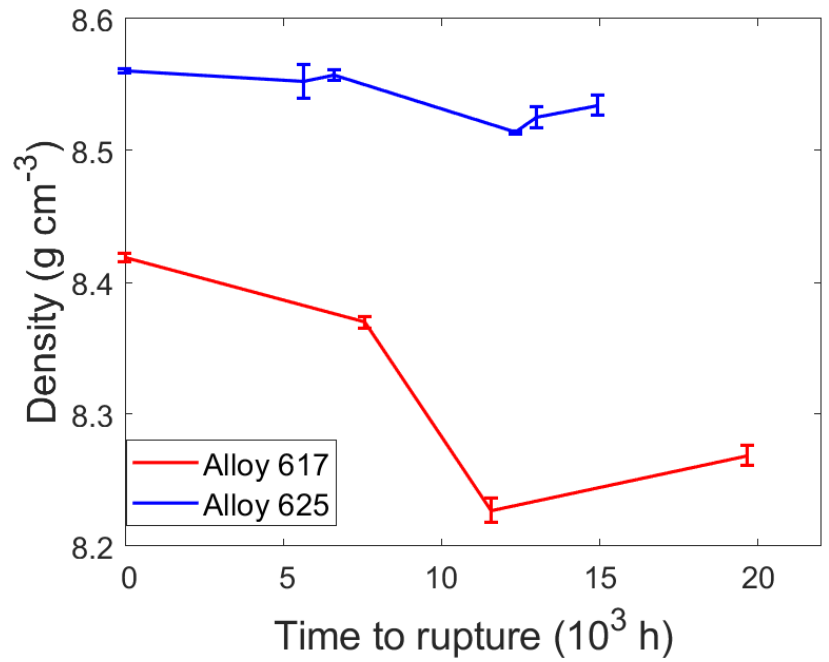
Figure 4. Time to rupture vs. specimen density.